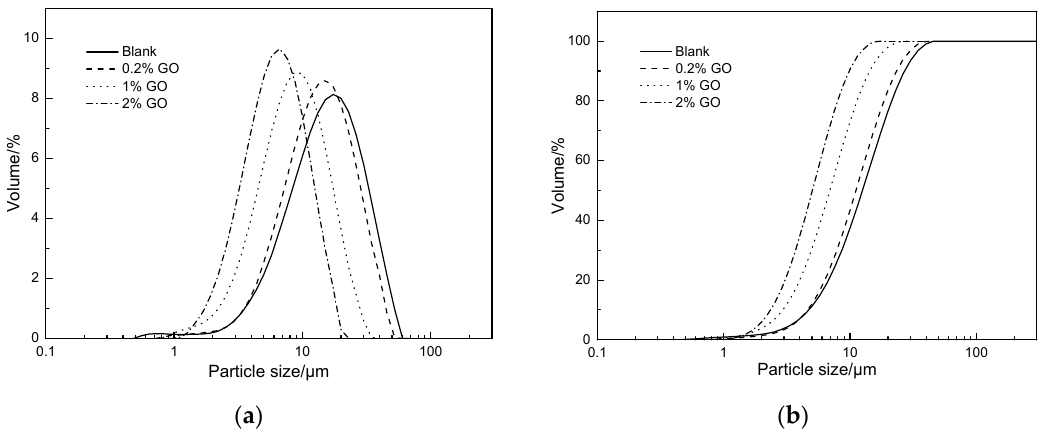
Figure 3. Particle size distribution of CaCO 3 prepared with different dosages of GO: ( a ) Differential distribution, and ( b ) integral distribution.